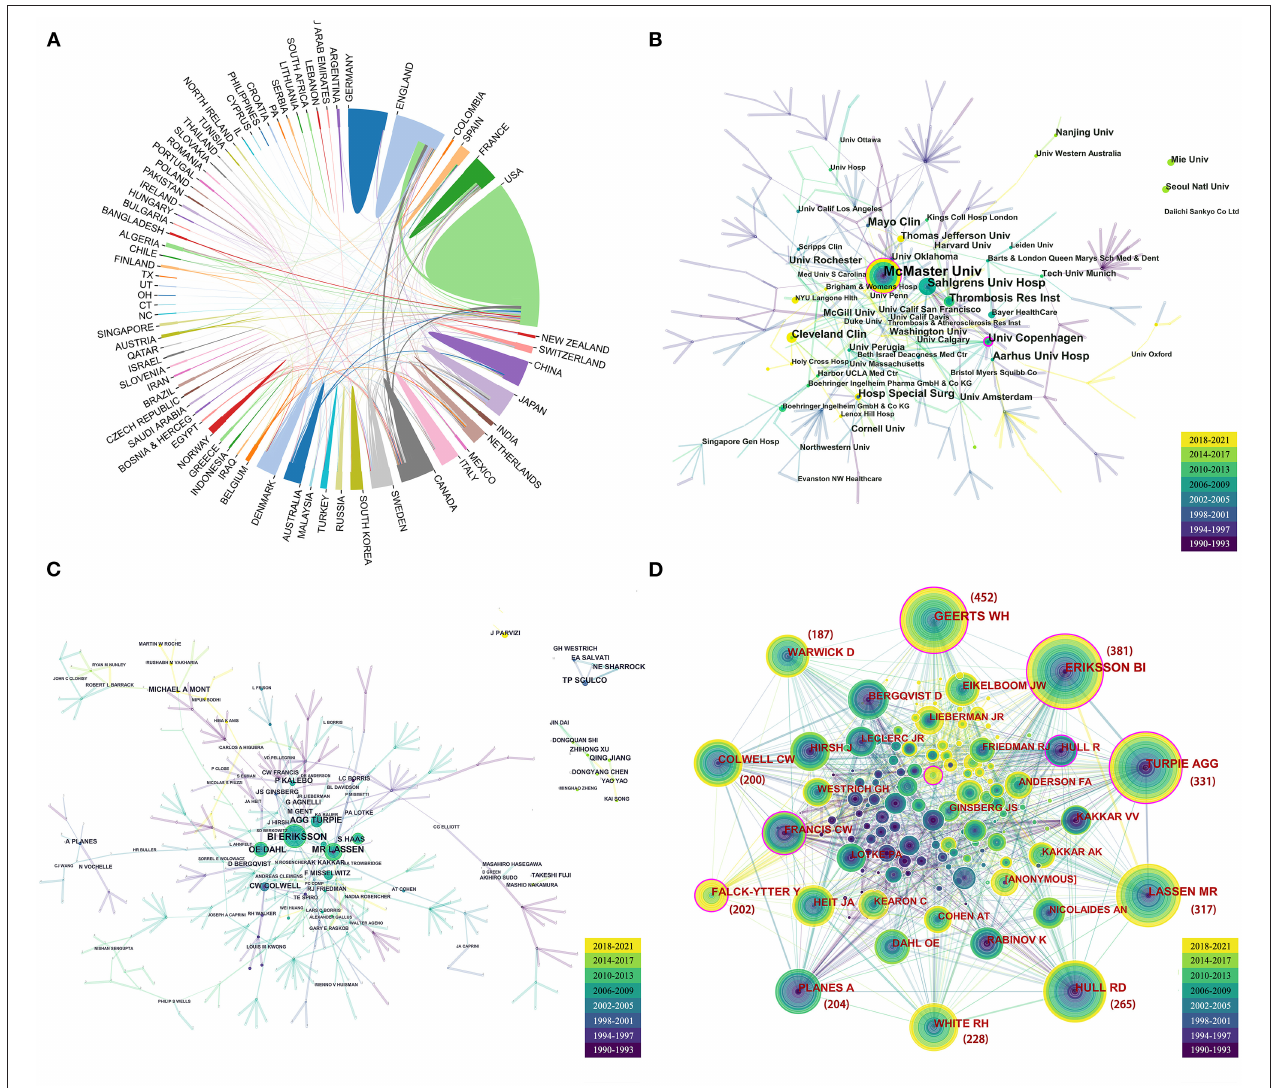
FIGURE 3 | Cooperation network among countries (A) , institutions (B) , and authors (C) and the graph of co-cited author analysis (D) . The nodes in the graph represent institutions or authors, and lines between the nodes represent the collaborative relationships and co-cited relationships. The various colors in the nodes represent the different years, and the larger the node area, the greater the number of publications and co-citations. The nodes with purple rings represent high centrality and are considered to be pivotal points in the